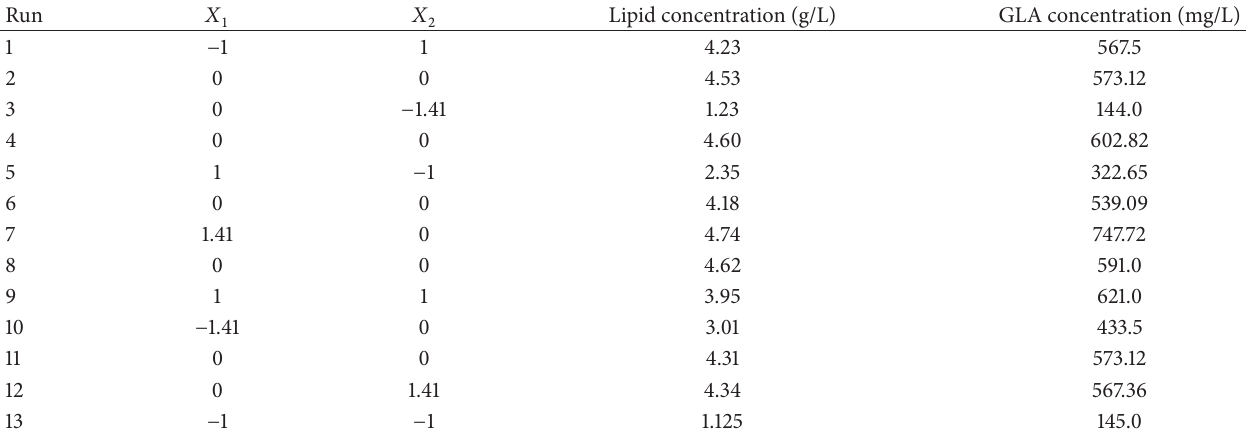
Table 2: Experimental design and test results of lipid and GLA produced by Cunninghamella bainieri 2A1 in the submerged